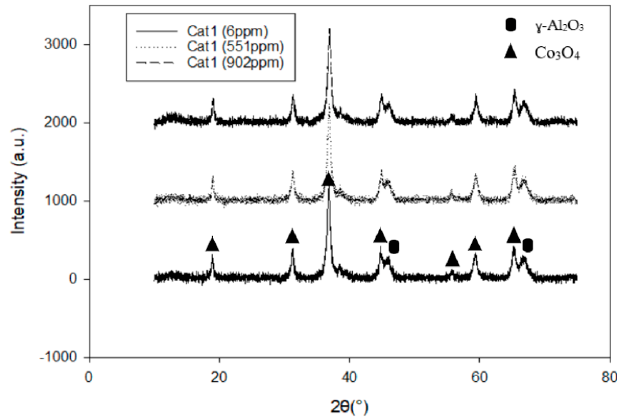
Figure 1. XRD patterns for 20%Co/0.5%Re/ γ -Al 2 O 3 with different K loadings.